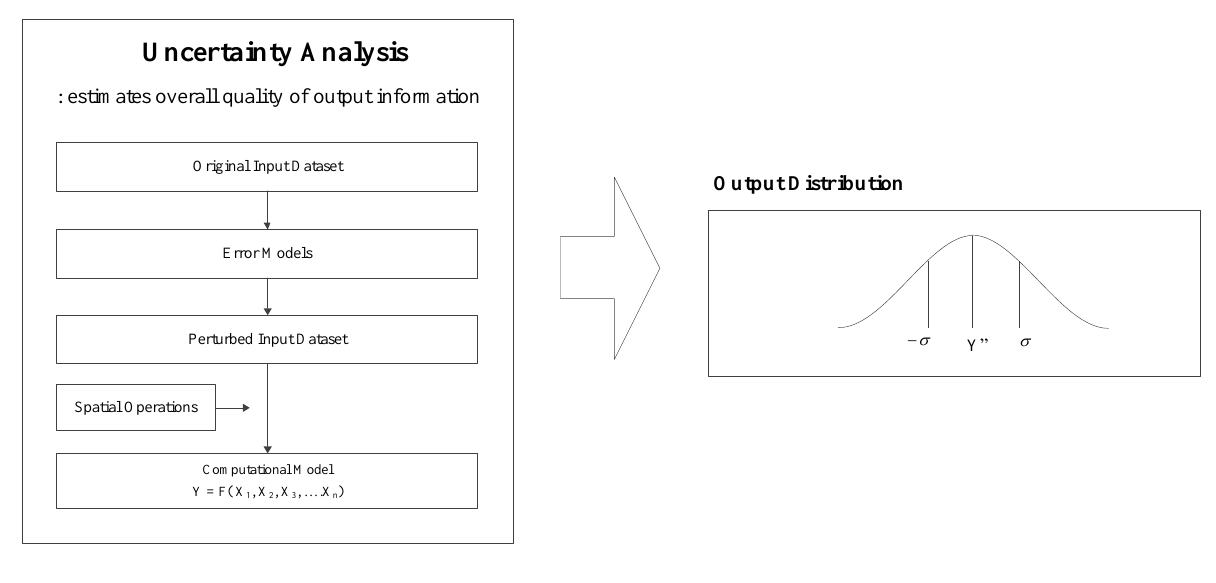
Figure 7. Conceptual view of uncertainty analysis method.